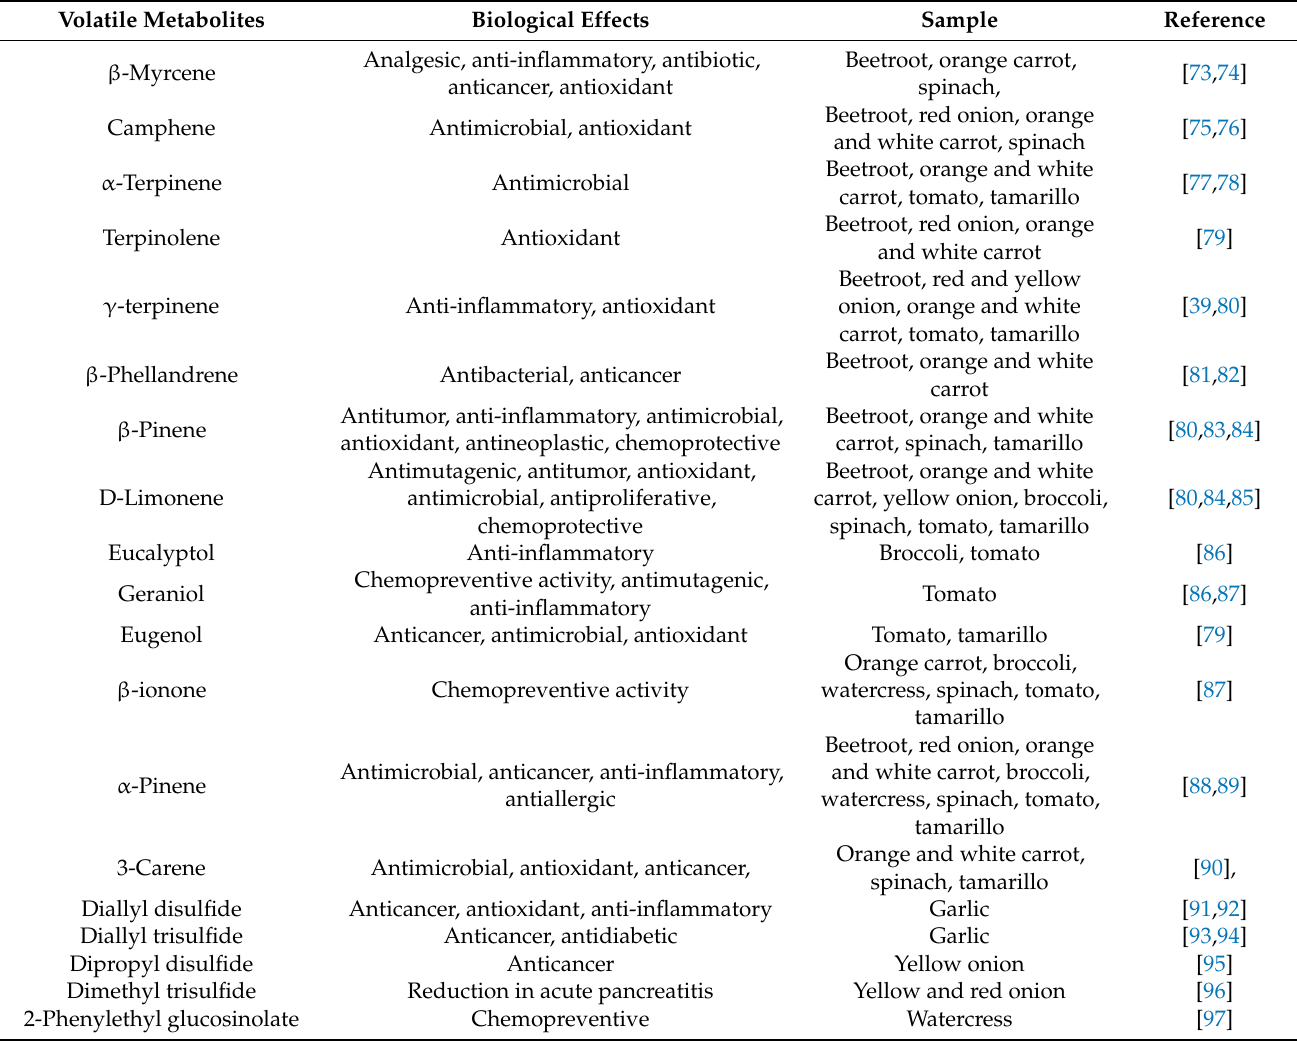
Table 1. Biological effects of some volatile metabolites identified in the studied fruits and